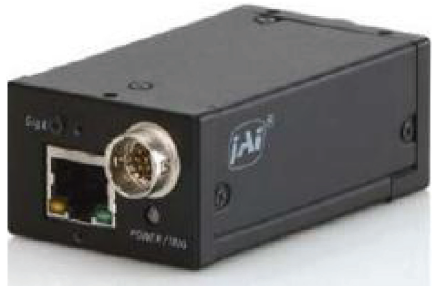
Figure 2: Diagram of CCD camera.